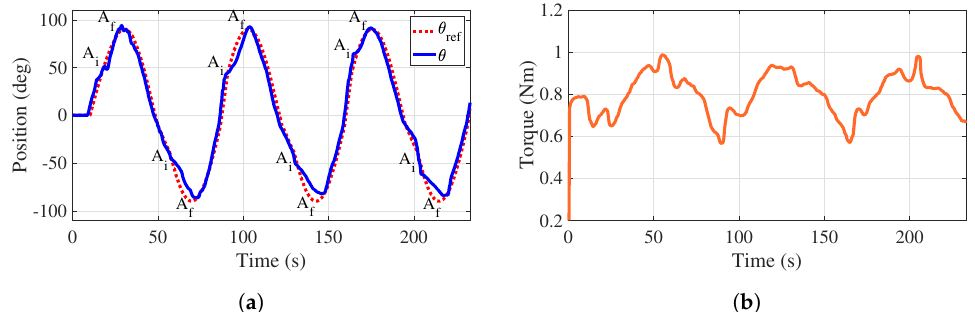
Figure 10. Active-assisted phase. Trajectory tracking and total torque behaviors with load. ( a ) Handle position. ( b ) Torque